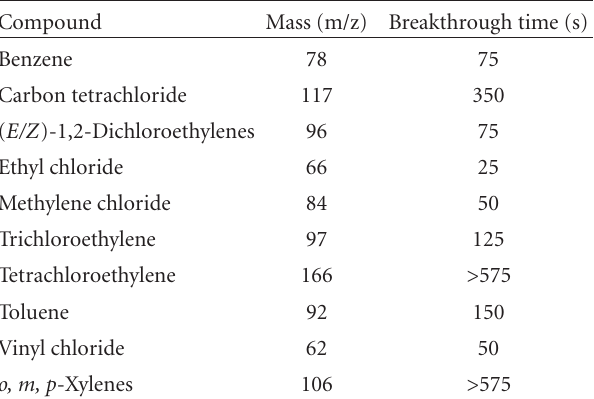
Table 6: Breakthrough study